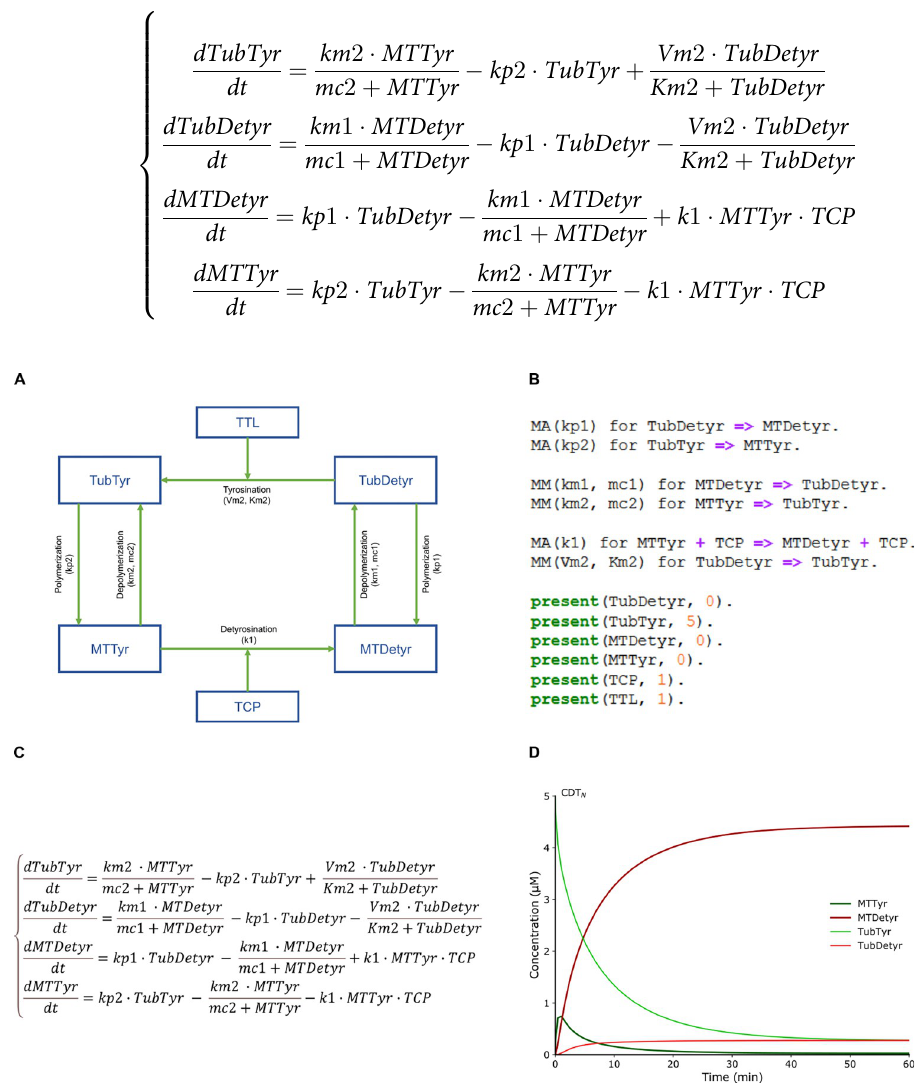
Fig 1. Schematic outline of our mechanistic model building method. ( A ) Influence diagram of the detyrosination/ tyrosination cycle. ( B ) Chemical Reaction Network of the detyrosination/tyrosination cycle in BIOCHAM syntax with either mass action law kinetics (MA) or Michaelis-Menten kinetics (MM), plus initial concentrations. ( C ) Parametric Ordinary Differential Equation (ODE) derived from the Chemical Reaction Network. ( D ) Unperturbed numerical simulation of the computational model CDT N , parameterized with kinetics values taken from the literature and hypothesis.